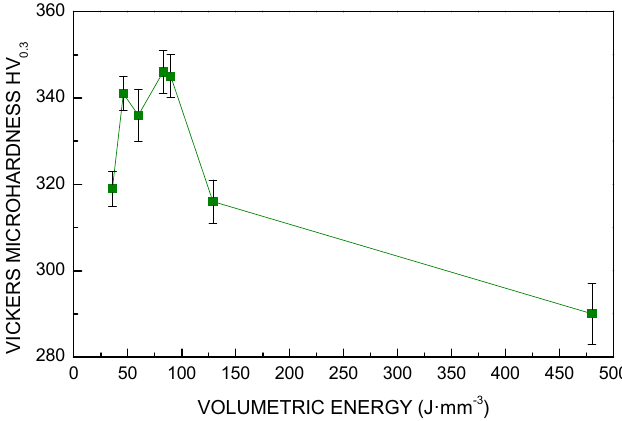
Figure 10. Vickers microhardness as a function of VED .